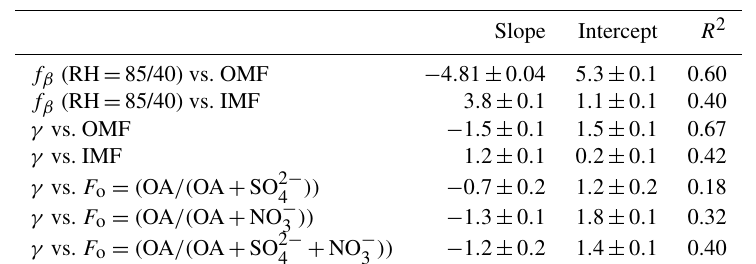
Table 2. Linear fits of the extrapolated f β (85/40) versus OMF and IMF for the eight cases found. The values of the adjustments between γ and OMF/IMF are also reported. Finally, regarding the amount of IA ( F o ), F o is defined by (a) F o = OA /( OA + SO 2 − + NO − ) , and (c) F o = OA /( OA + SO 2 − ) and linearized versus γ . OA /( OA + NO − 3 4 3